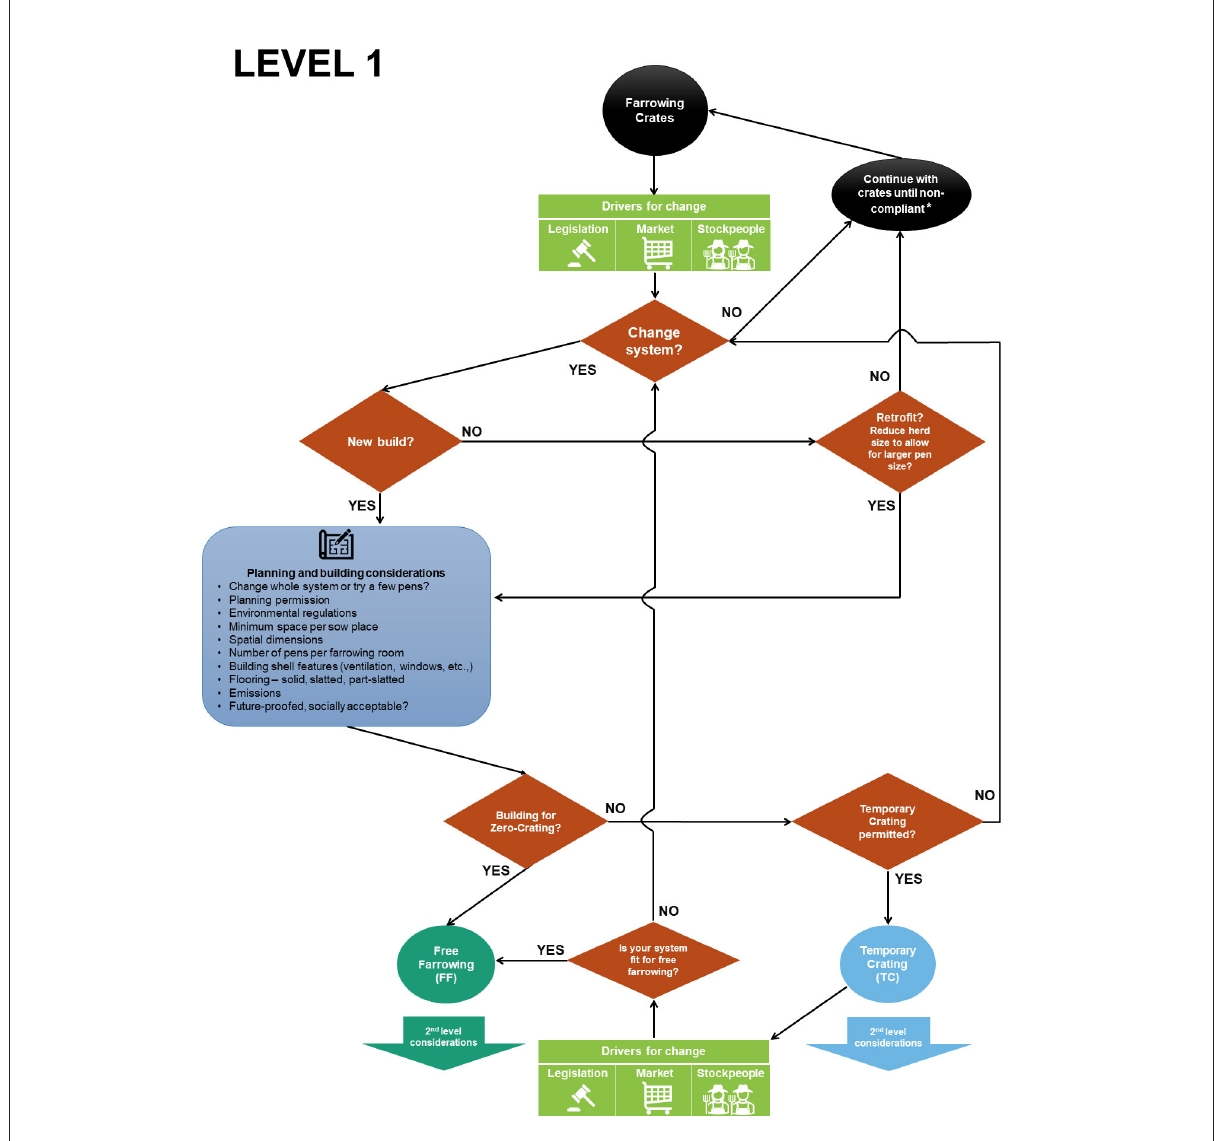
FIGURE2 First level decision tree for transition from farrowing crates to alternative accommodation. *Assumes a transition period will be in place before farrowing crates are no longer permitted. Note that it is possible current systems may become non-compliant based on current genotypes not just permanent confinement. This is because hyperprolific sows and their litters may not be able to be accommodated in standard farrowing crate and pen